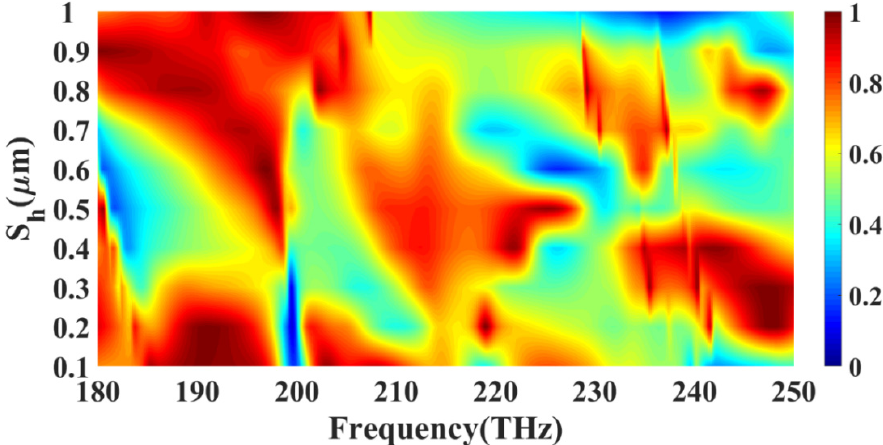
Figure 5. Calculated absorption response for the different size values of the borophene squared patch.